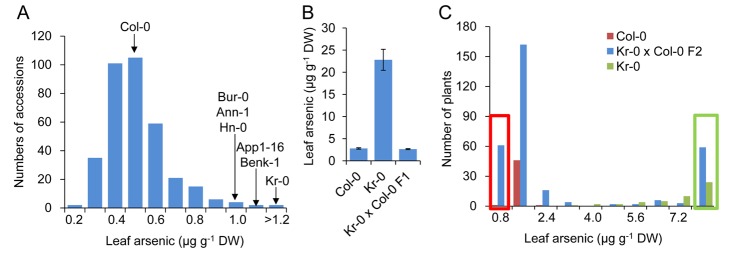
High leaf arsenic concentration in A. thaliana Kr-0 is controlled by a single recessive locus.(A) The frequency distribution of leaf arsenic concentrations in 349 A. thaliana accessions. Arrows indicate leaf arsenic concentration of accessions highlighted in the text. (B) Leaf arsenic concentration in A. thaliana accession Col-0, Kr-0, and their F1 progeny. Data represent the mean leaf arsenic concentration ± SE (n = 7–12). (C) The frequency distribution of leaf arsenic concentrations in F2 progeny of a cross between Kr-0 and Col-0. Red box indicates F2 plants used to create the low arsenic pool for XAM; Green box indicates F2 plants used to create the high arsenic pool for XAM. All leaf arsenic concentration data are accessible using the digital object identifiers (DOIs) 10.4231/T9H41PBV and 10.4231/T9QN64N6 (see http://dx.doi.org/) and available in Data S1.